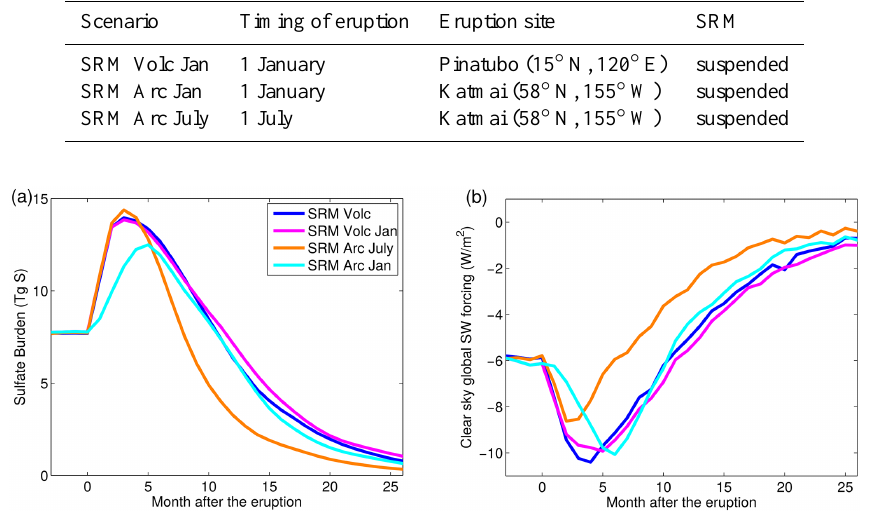
Table B1. Sensitivity scenarios run only with MAECHAM5-HAM-SALSA. Here Jan refers to a volcanic eruption in January and Arc to an Arctic eruption at the site of Katmai.